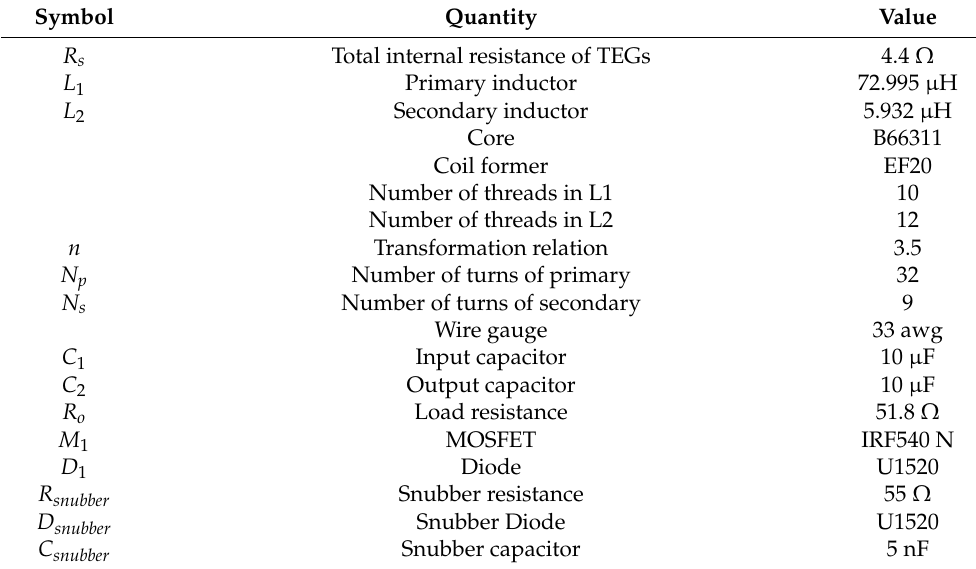
Table 3. Components Used in Prototype.